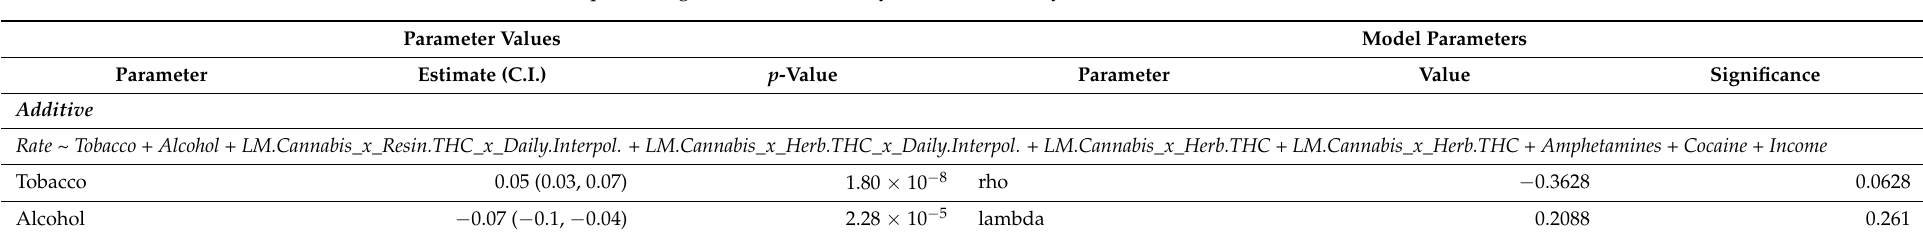
Table 4. Multivariate Geospatial Regression for Down Syndrome (Trisomy